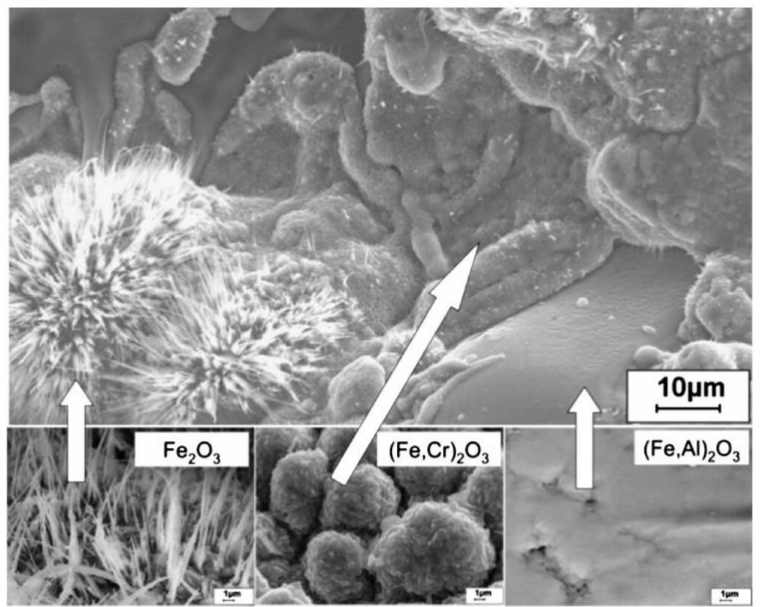
Figure 8. Different morphology of the oxide scales formed on the various lamellae of arc-sprayed coating Cr6B3Al4. Reprinted with permission from ref. [8]. Copyright 2013